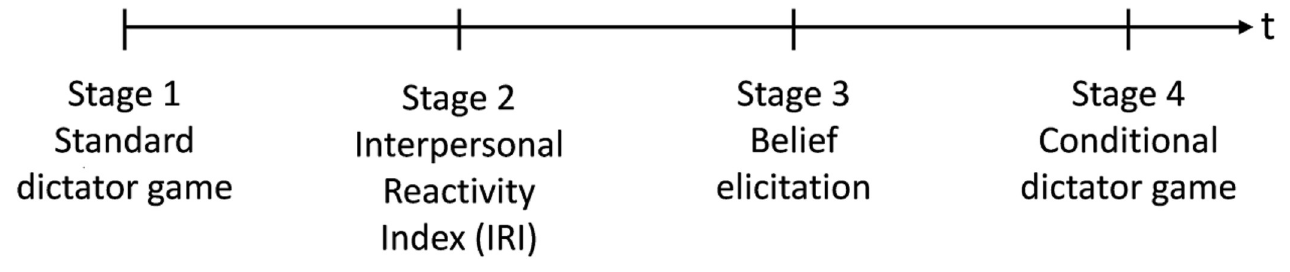
Fig 1. Stages of the